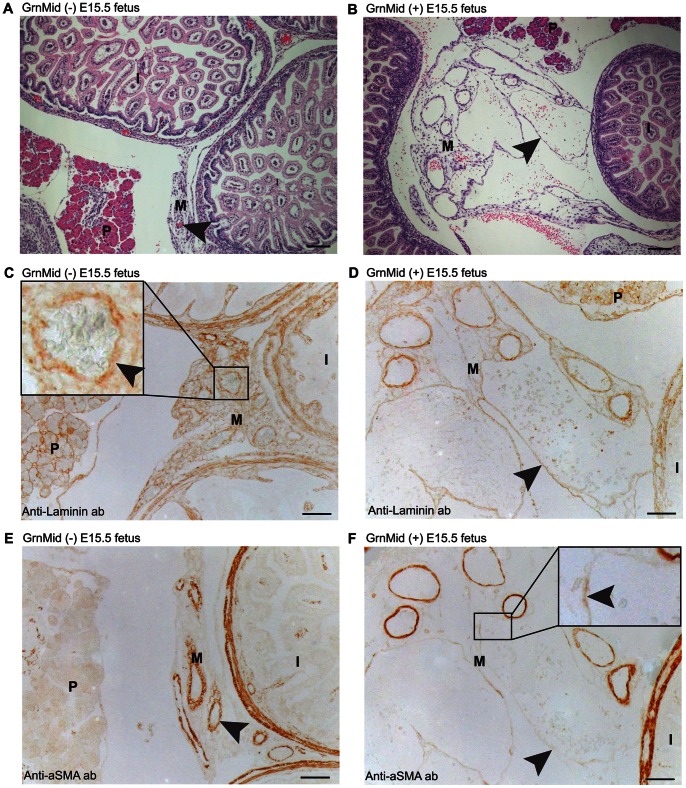
Vascular abnormalities were first observed at E15.5 in the Tie2-Grn positive embryos.A comparison of mesenteric vessels (black arrow heads) in (A) a Tie2-Grn negative and (B) a Tie2-Grn positive fetus stained with H&E. Note the presence of highly distended vessels in (B). Blood vessels stained strongly for laminin, a basement membrane protein in Tie2-Grn negative fetuses (insert, black arrow head) (C), but in Tie2-Grn positive fetuses (D) laminin stained weakly, especially in the most distended vessels. Mesenteric vessels from Tie2-Grn negative fetuses (E) showed extensive coverage with smooth muscle α-actin positive mural cells, while in Tie2-Grn positive fetuses (F) distended vessels were in large part negative for smooth muscle α-actin positive mural cells (black arrow heads). P, pancreas; I, intestines; M, mesentery. Scale bars denote 20 µm. Images were obtained from the GrnMid line.